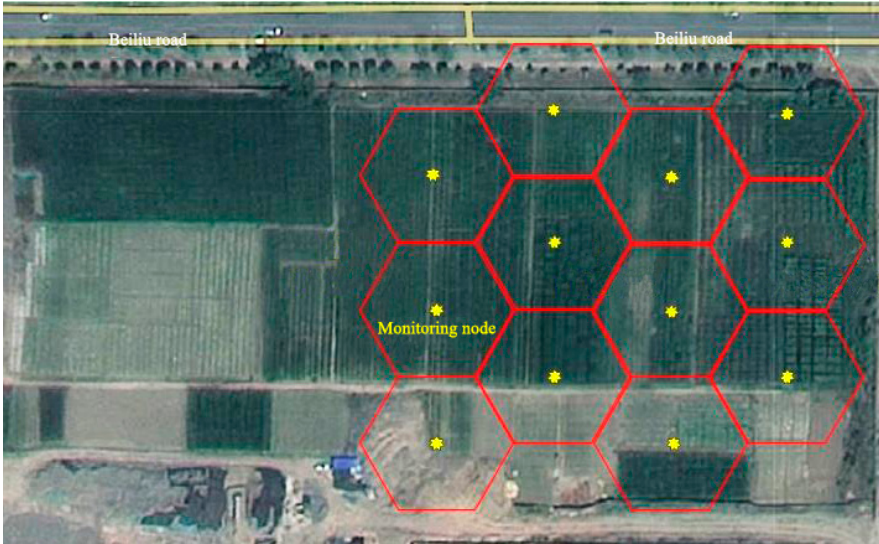
Figure 4. Deployment of monitoring nodes in experimental plots.